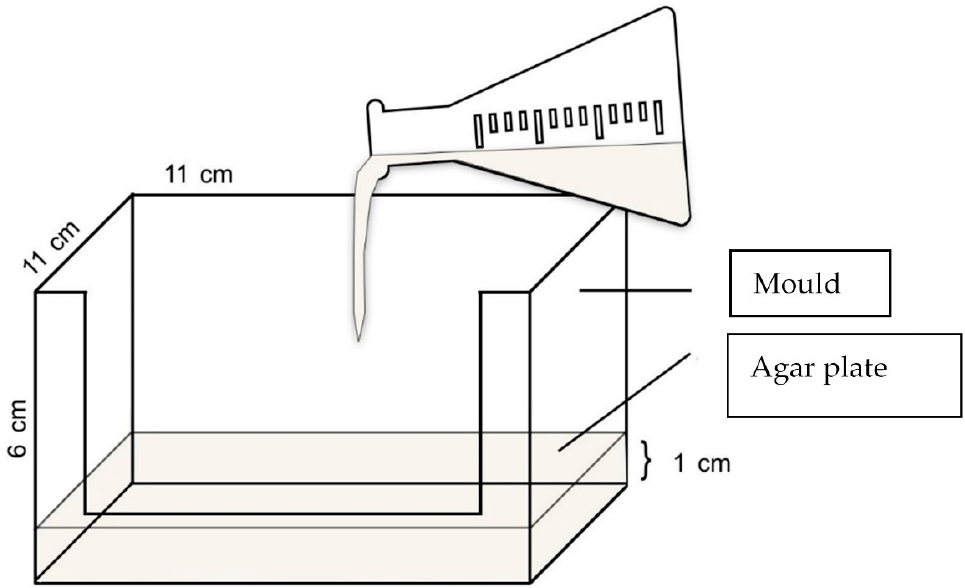
Figure 2. A schematic drawing of the mold for agar herbicide plates.